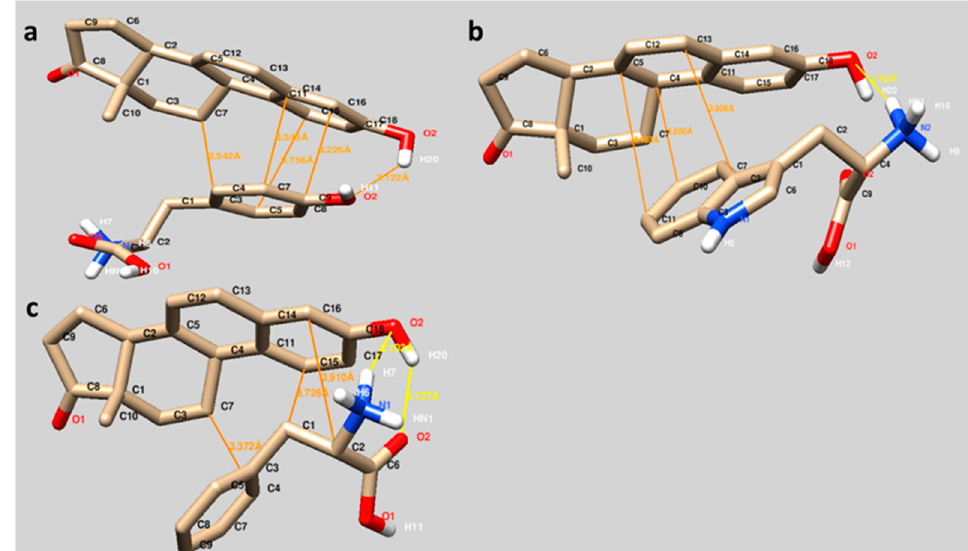
Figure 3. Molecular docking of Equ to three different amino acids Tyr ( a ), Trp ( b ) and Phe ( c ). Hydrophobic interactions and hydrogen bonding have been indicated with orange and yellow lines, respectively. Table 1. The theoretical lowest binding energy (kcal/mol) and free energy (kcal/mol) results of 11- MUA and Equ with respect to Tyr, Trp and Phe.